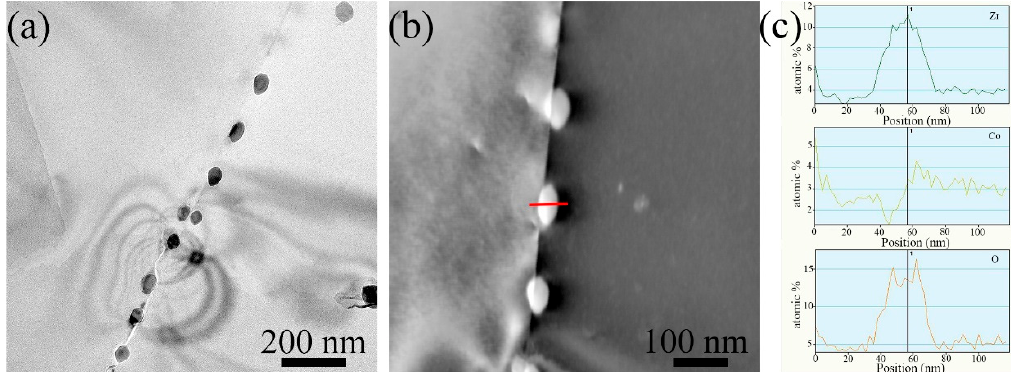
Figure 7. TEM images of Zr 50 Co 50 alloys: ( a ) microstructure of the as-cast alloy; ( b ) second phase particles along the GBs; ( c ) EDS pattern.